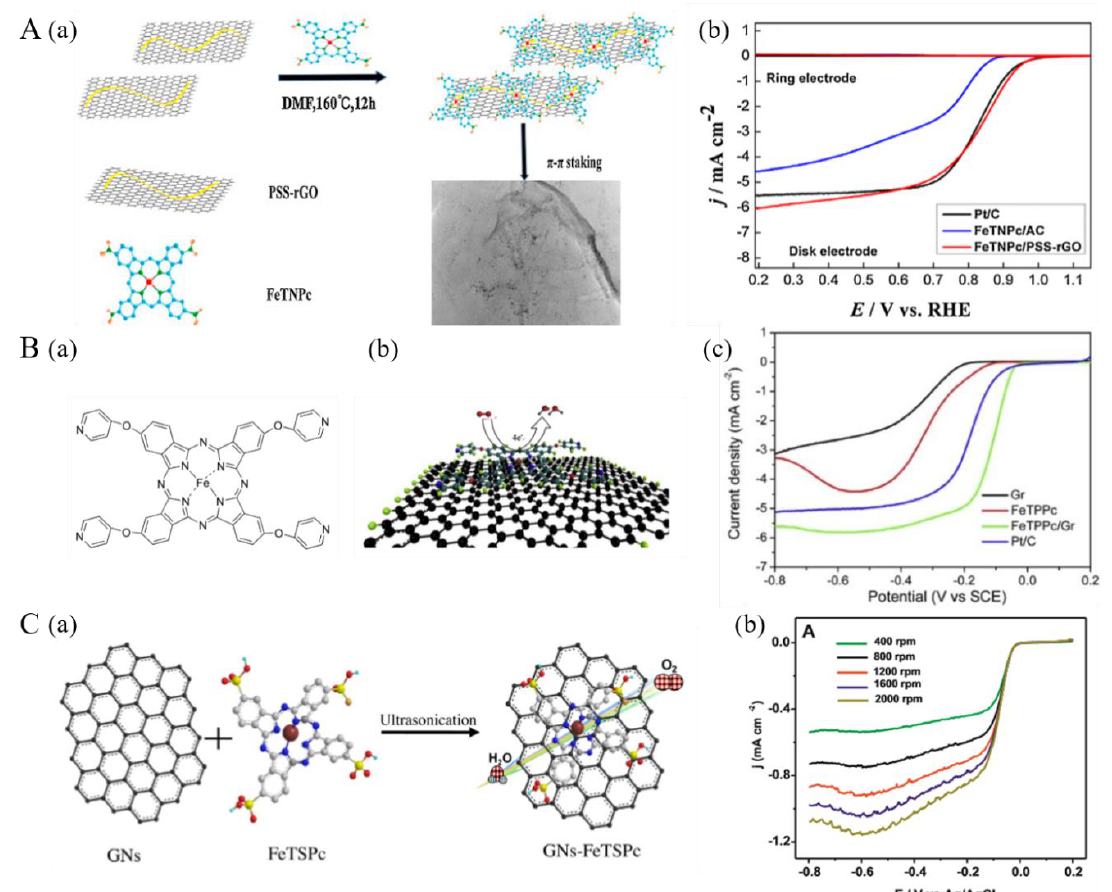
Figure 4. ( A ) Synthetic procedure for FeTNPc / PSS-rGO composites and ( b ) RRDE voltammograms Figure 4. A Synthetic procedure for FeTNPc/PSS-rGO composites and ( b ) RRDE voltammograms of Pt/C, of Pt / C, FeTNPc / AC, and FeTNPc / PSS-rGO, adapted from ref [42] Copyright 2016 Elsevier. ( B ) ( a FeTNPc/AC, and FeTNPc/PSS-rGO, adapted from ref [42] Copyright 2016 Elsevier. B ( a ) Molecular